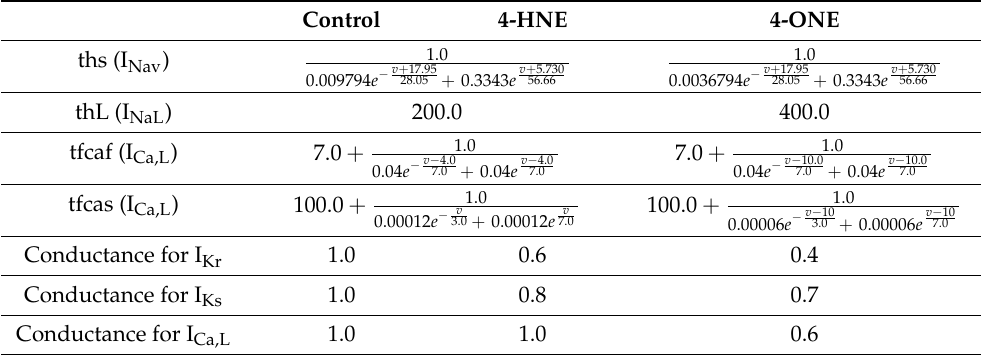
Table 1. The input values for the simulation of AP using